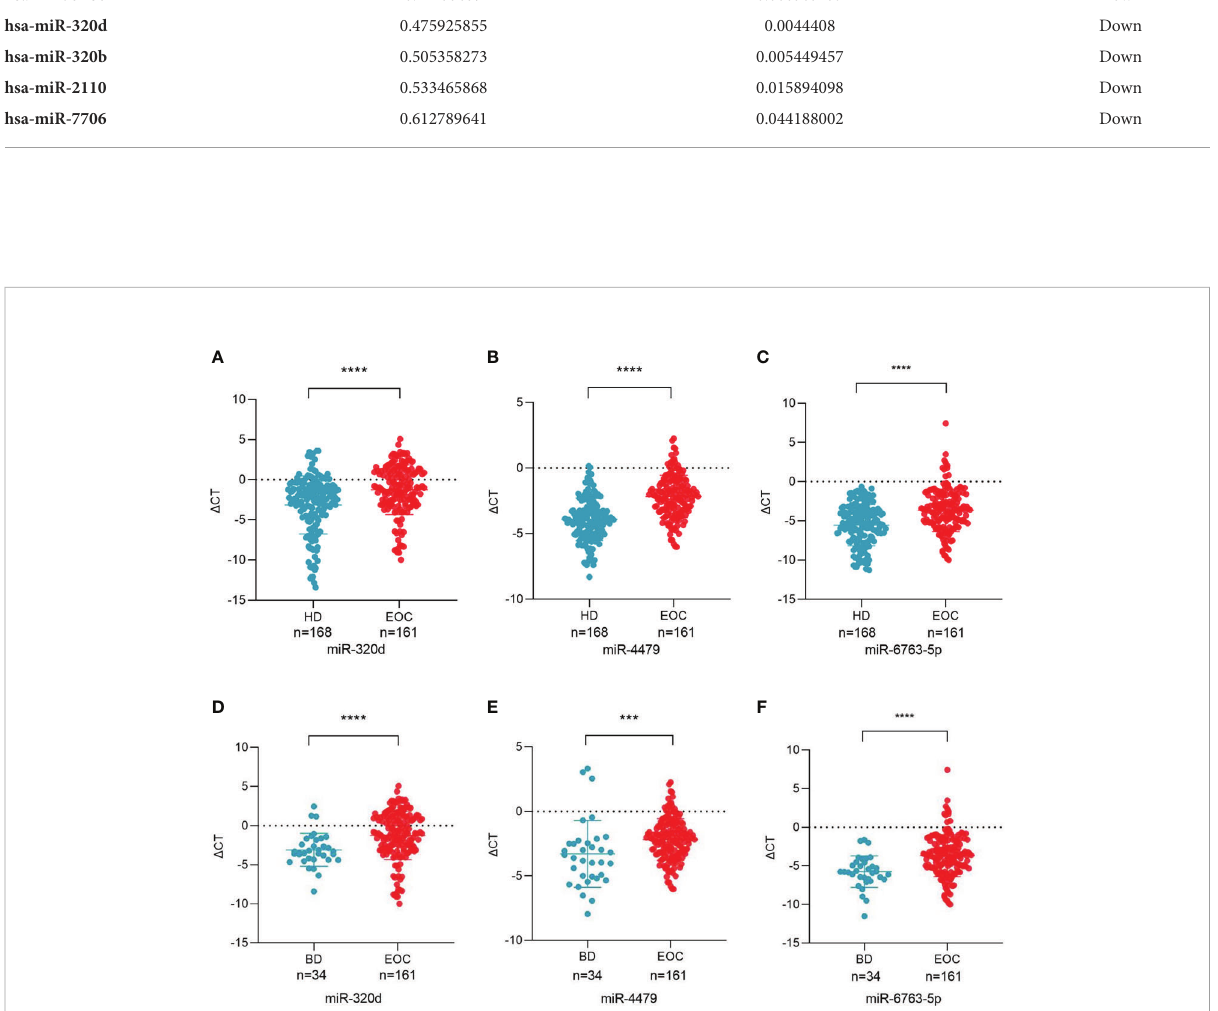
FIGURE 3 Plasma exosomal miR-320d, miR-4479, and miR-6763-5p are potential biomarkers of EOC. (A-C) Scatter plots comparing the exosomal miR- 320d, miR-4479, and miR-6763-5p levels in the plasma of healthy donors (n = 168) and EOC patients (n = 161) (**** P < 0.0001). (D-F) Scatter plots comparing the exosomal miR-320d, miR-4479, and miR-6763-5p levels in the plasma of EOC patients (n = 161) and benign diseases patients (n=34) (*** P < 0.001, **** P < 0.0001). HD, Healthy donor; EOC, epithelial ovarian cancer; BD, benign